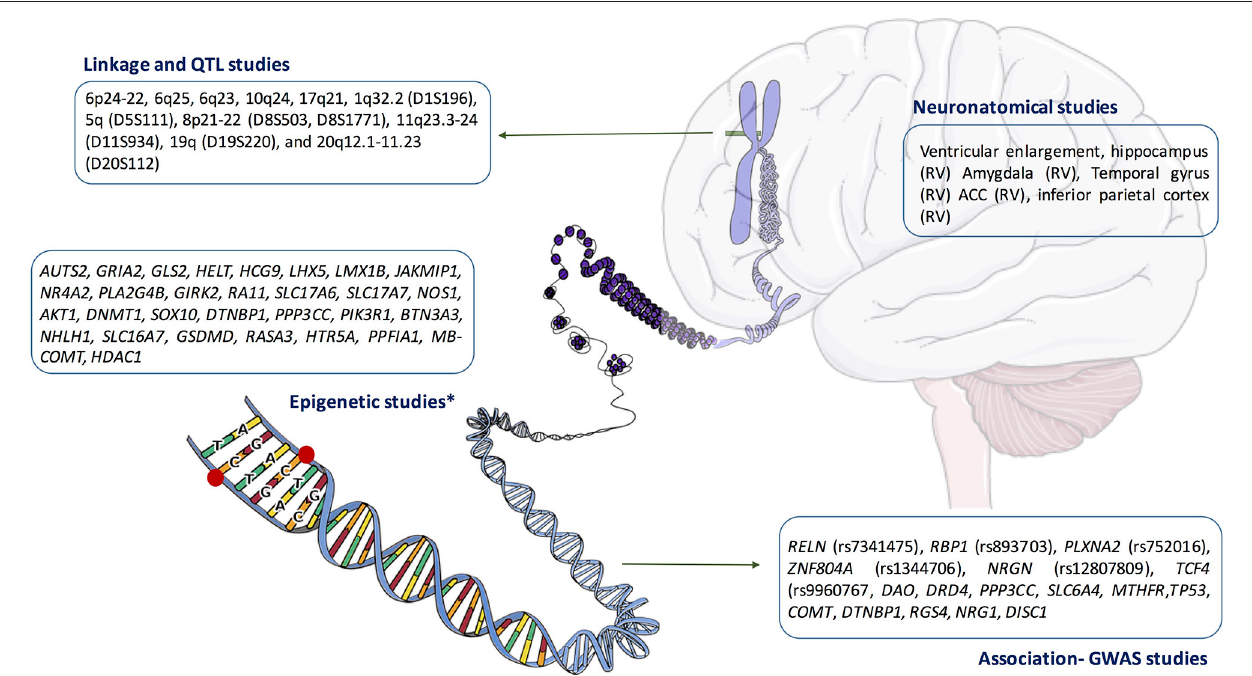
FIGURE 2 | Summary of the main findings in the neurobiology of schizophrenia. ACC, anterior cingulate cortex; RV, reduce volume. * Main epigenetic findings in human brain samples.